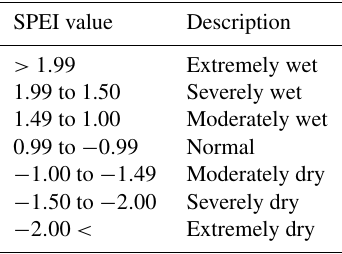
Table 1. SPEI classification of dry and wet events (from Chen et al.,